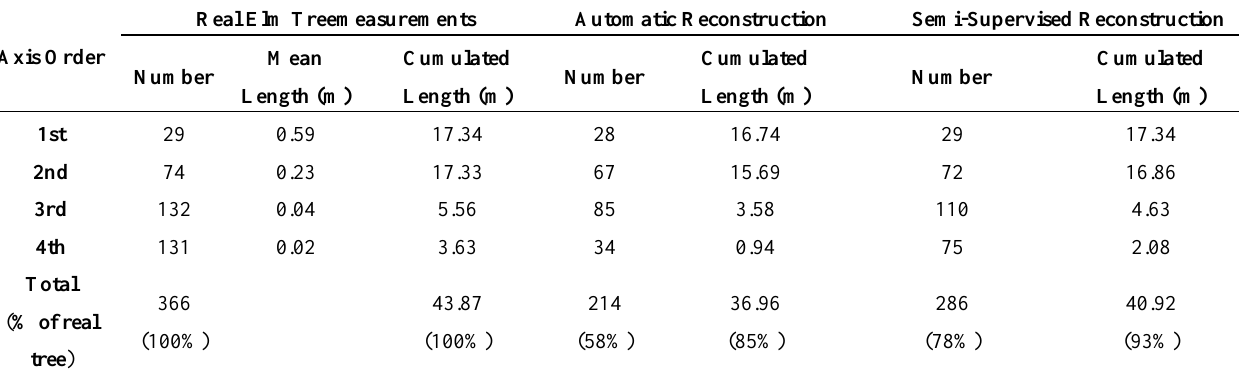
Table 1. Validation results for the elm tree reconstruction. Real data were acquired in the field and compared to automatic reconstruction and semi-supervised